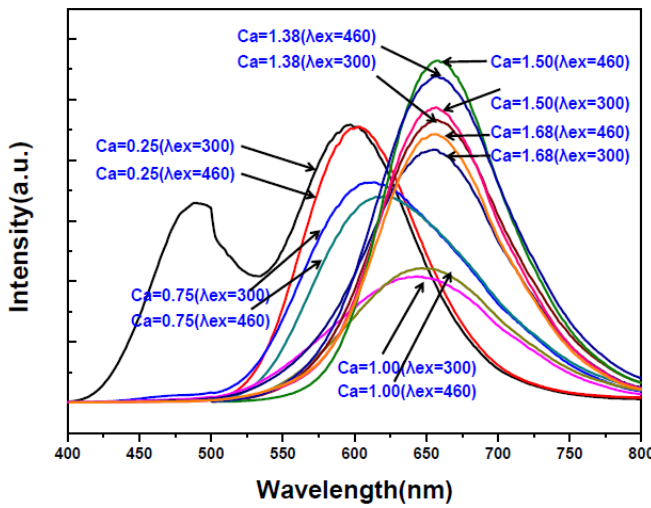
Figure 11. Emission spectra of the products synthesized with various Ca contents under excitation of λ = 300 and 460 nm.